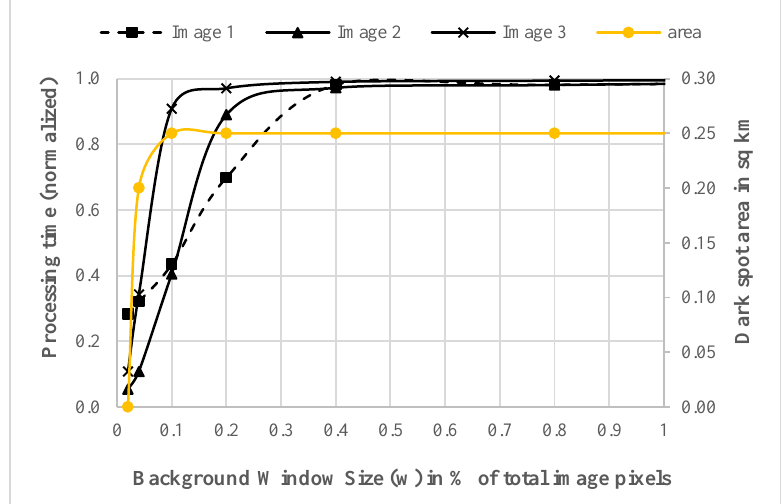
Figure 4. Processing time and dark spot area against window size for k = 0.2.